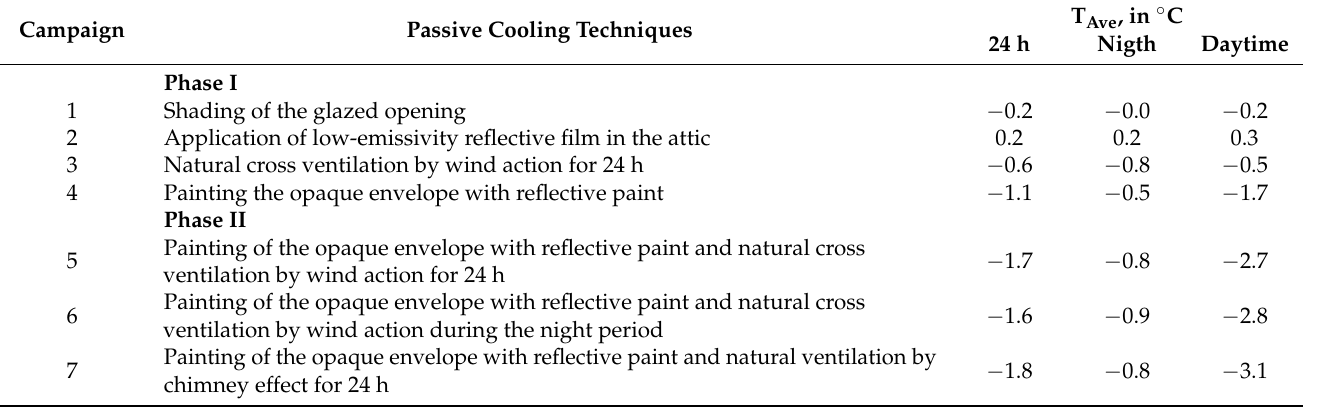
Table 3. Temperature differences between Cell 01 and Cell 02, in ◦